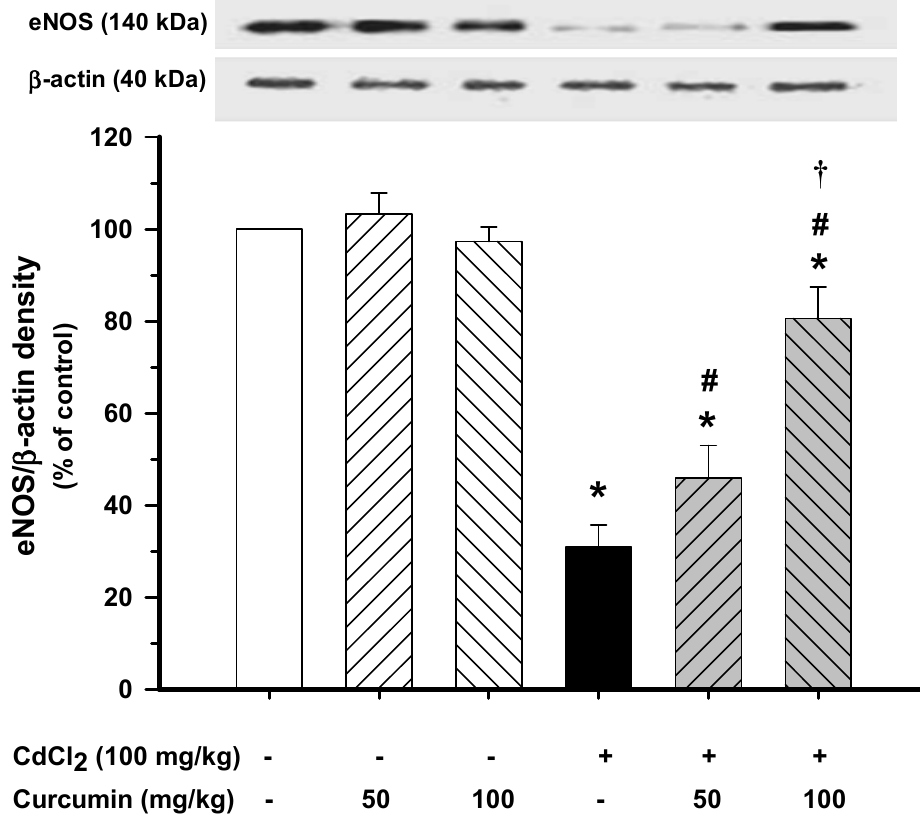
Figure 2. Effects of curcumin co-administration on expression levels of eNOS protein in thoracic aortas. Plots show the densitometric intensities of eNOS protein expressions for each condition, normalized against β -actin expression and presented in percent of normal controls. Results are expressed as mean ± S.E., Each column represents the mean of four experiments. * p < 0.05 compared with normal control group; # p < 0.05